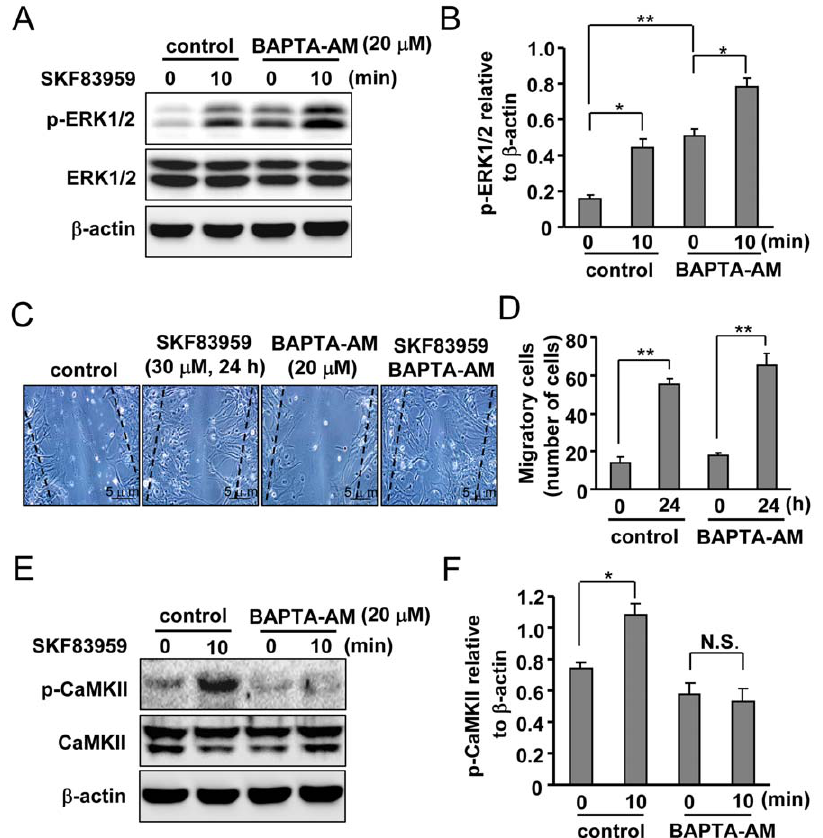
Figure 3. Contribution of intracellular Ca 2 + to SKF83959-induced ERK1/2 phosphorylation. (A) Effects of BAPTA-AM (20 m M, 30 min) on SKF83959 (30 m M, 10 min)-induced ERK1/2 phosphorylation. (B) Quantification of ERK1/2 phosphorylation level in astrocytes pre-incubated with BAPTA-AM and treated with SKF83959 (Mean 6 S.E., n=3, * P , 0.05, 10 min vs. 0 min, ** P , 0.01, BAPTA-AM 0 min vs. control 0 min). (C) Roles of BAPTA-AM (20 m M, 30 min) in SKF83959 (30 m M, 24 h)-induced migration of astrocytes. Bar: 5 m m. (D) Quantification of migration in astrocytes pre- incubated with BAPTA-AM and treated with SKF83959 (Mean 6 S.E., n=3, ** P , 0.01, 24 h vs. 0 h). (E) Effects of BAPTA-AM (20 m M, 30 min) on SKF83959 (30 m M, 10 min)-induced CaMKII phosphorylation. (F) Quantification of CaMKII phosphorylation level in astrocytes pre-incubated with BAPTA-AM and treated with SKF83959 (Mean 6 S.E., n=3, * P , 0.05, 10 min vs. 0 min). N.S.: no significance.